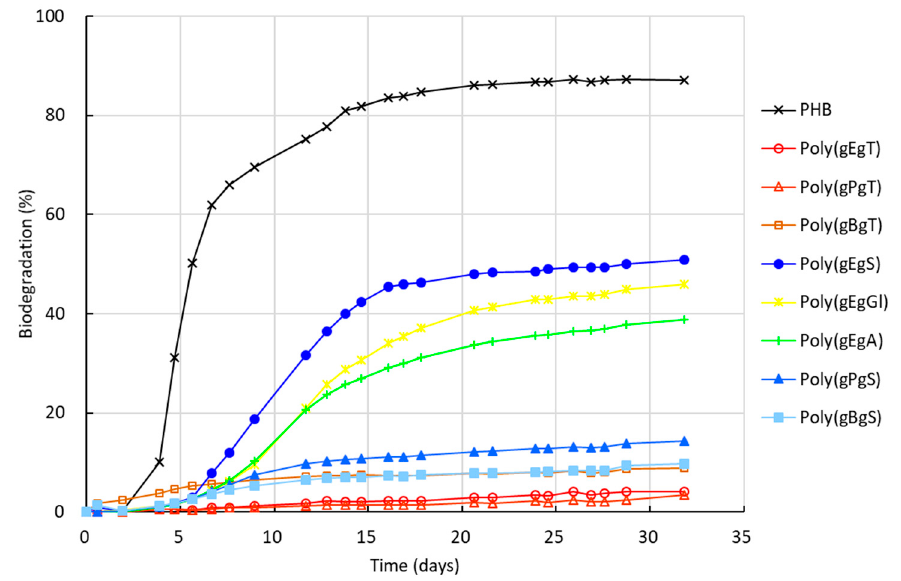
Figure 4. Biodegradation of the poly(ester amide)s in activated sludge.